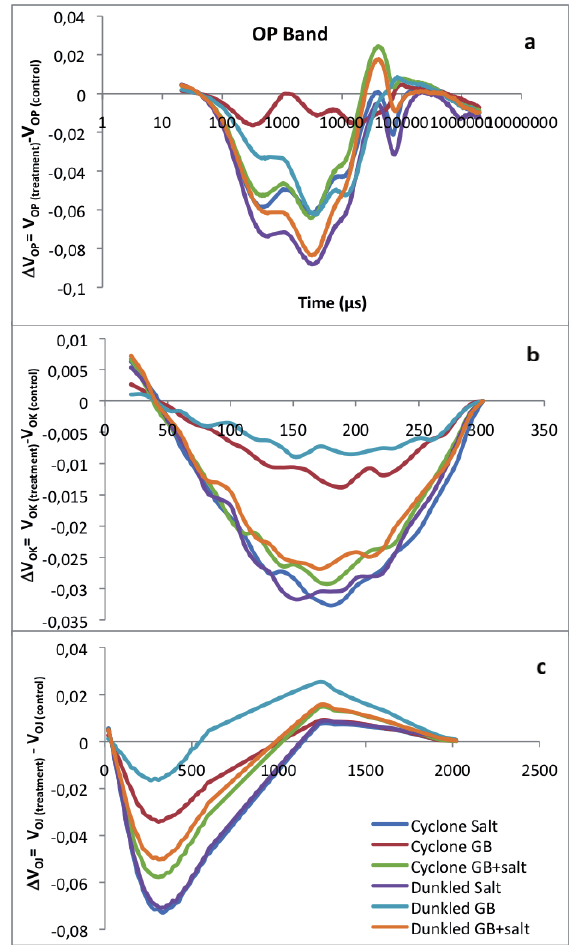
Fig. 4: ΔVOP, ΔVOK, ΔVOJ of two cultivars of canola ( Brassica napus L.) when three week old plants were subjected to foliar application of glycinebetaine and salt stress for further two